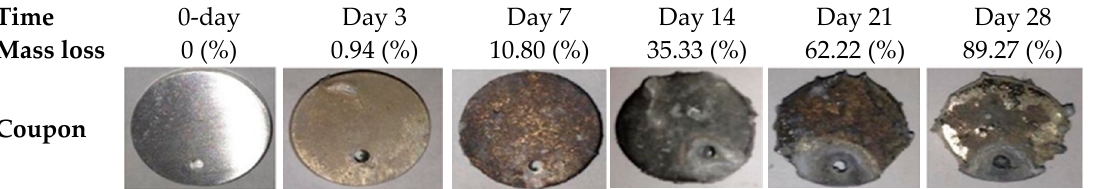
Figure 4. Mass loss of Mg–1.2Zn–0.5Ca (%) coupon as a function of time during immersion testing in SBF at pH 7.3–7.8 and 37 °C for a period of 28 days.